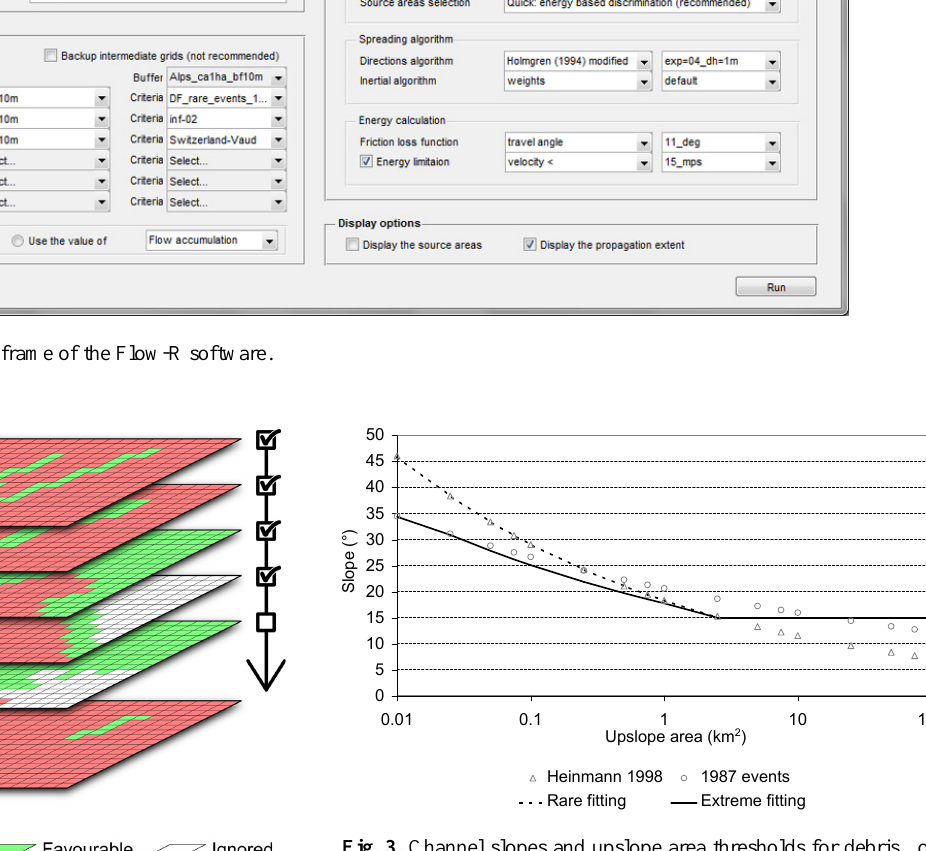
Fig. 3. Channel slopes and upslope area thresholds for debris flow initiation for rare and extreme events. After Horton et al. (2008), Heinimann (1998), and Rickenmann and Zimmermann